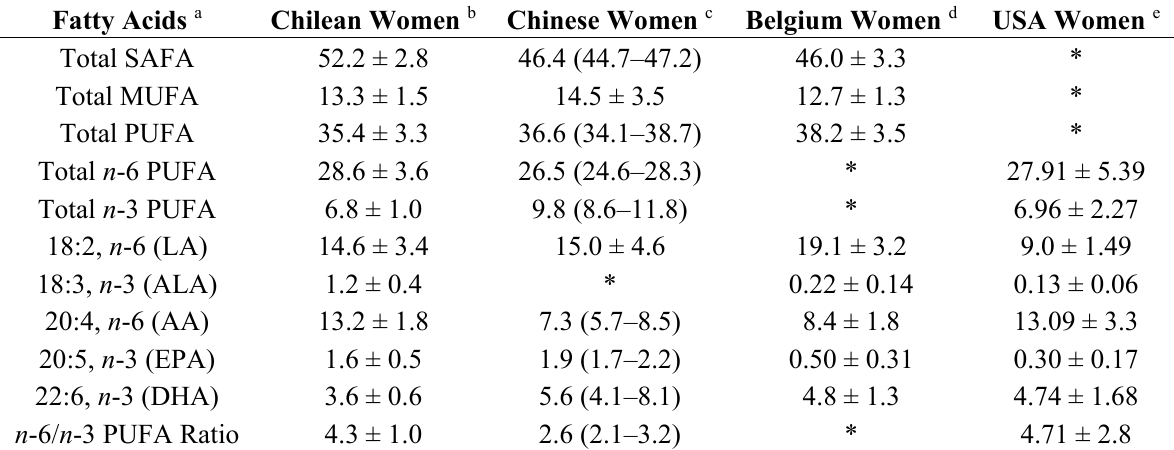
Table 5. Fatty acid composition of maternal erythrocyte membrane phospholipids Fatty Acids